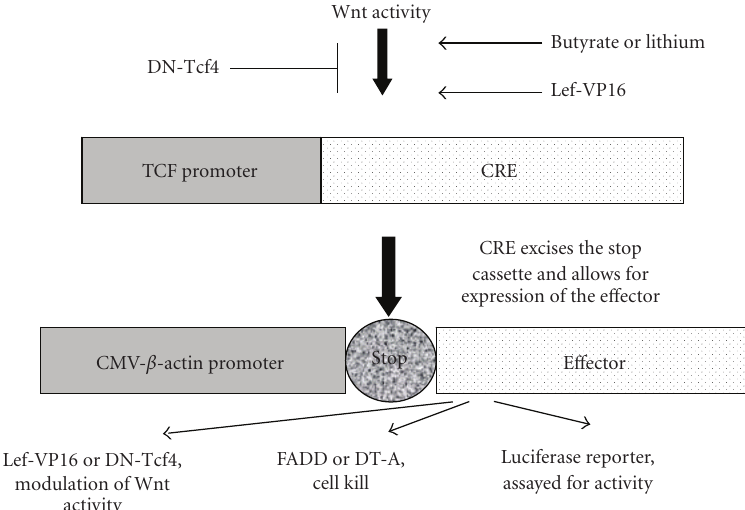
Figure 1: Schematic of the model system. Wnt signaling, which can be up- or downregulated by pharmacological or genetic modulators, promotes expression from Wnt-sensitive promoters, driving production of Cre recombinase. Cre excises stop cassettes from floxed expression vectors, allowing for production of e ff ectors. Included in the e ff ectors are genes that can positively or negatively feed back to influence Wnt activity and, hence, Cre expression. This model system can be generally applicable to any human disorder characterized by aberrant gene expression involving disorder-specific transcription factors, reproduced as per copyright agreement from